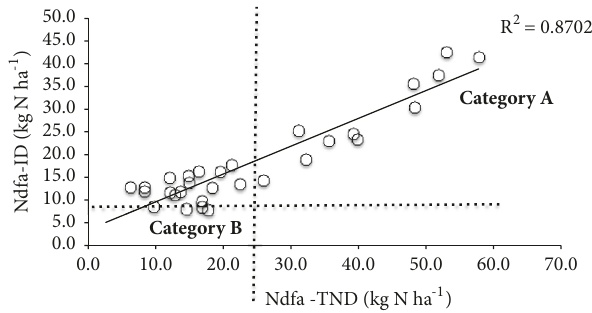
Figure 2: Relationship between Ndfa-ID and Ndfa-TND, as well as the partitioning of genotypes into two categories by utilizing a graphical method (Cate and Nelson, 1971). The two perpendicular lines (vertical and horizontal) separate the genotypes into two categories by maximizing the number of points in two quadrants or categories. By maximizing the number of points in two categories, the point where the vertical line intersects the X-axis (27kg Ndfa- TND) divides the genotypes into categories A and B (high and low Ndfa-TND). Ndfa-TND and Ndfa-ID: nitrogen derived from the atmosphere with total N difference and isotopic dilution methods, respectively